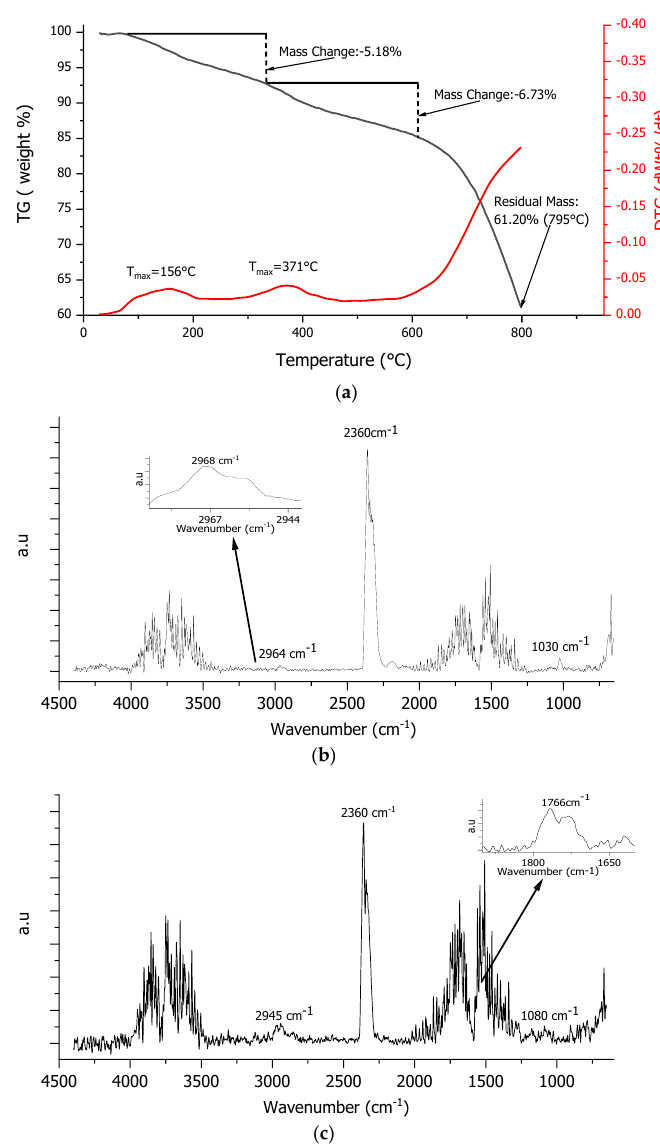
Figure 4. ( a ) Thermal degradation of graphene ethyl maleate (GEM). ( b ) Gas infrared spectra correlated with the degradation of GEM at 160 °C with (inside caption) the peak observed with the subtraction of water and ( c ) 380 °C with the peak observed with (inside caption) the subtraction of water. The second degradation step at 370 °C shows the presence of the former gasses together with carbonyl groups and an acrylate double bond evidenced only after the subtraction of the spectrum related to water between 2000 and 1600 cm − 1 .